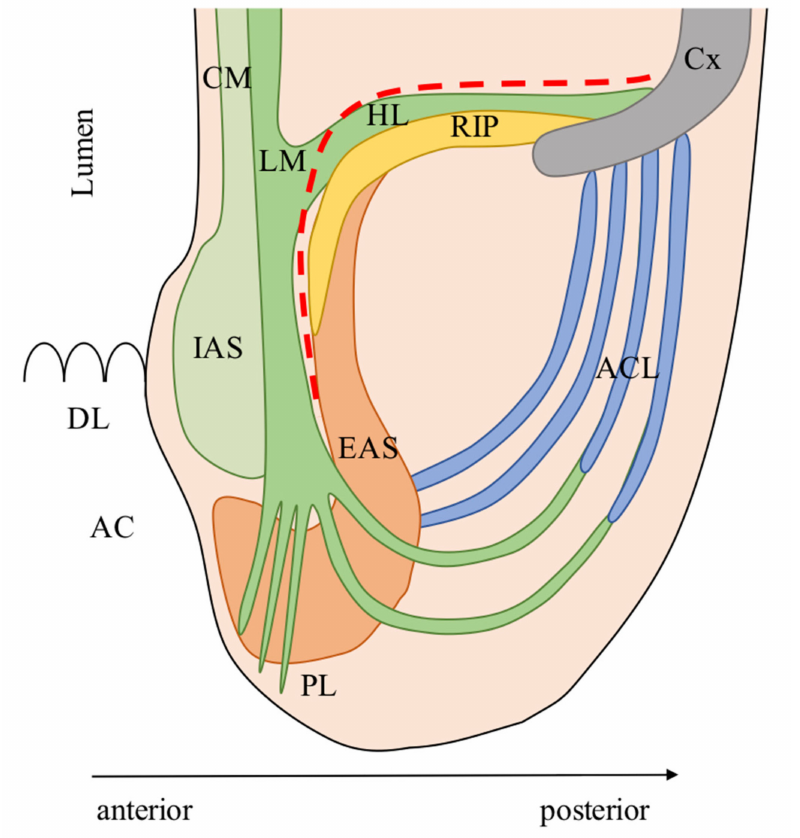
Figure 1. Posterior anatomy. AC: Anal canal; ACL: Anococcygeal ligament; Cx: Coccyx; CM: Circular muscle of the anal canal; EAS: External anal sphincter; HL: Hiatal ligament (sometimes referred as anococcygeal ligament by colorectal surgeons); IAS: Internal anal sphincter; LM: Longitudinal muscle of the anal canal; PL: Parks’ ligament; RIP: Raphe of iliococcygeus and pubococcygeus muscle; Red line: Dissection plane during intersphincteric resection. The anatomic model was designed according to the descriptions of Muro et al. [22]. Modified and reprinted with permission from ref. [20]. Copyright 2020 Turkish Journal of Colorectal